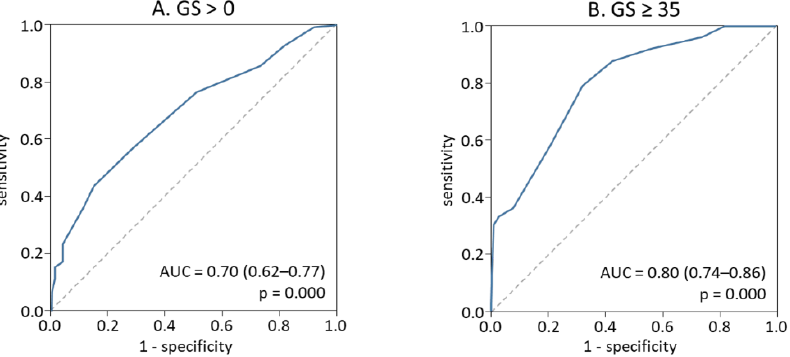
Figure 2. ROC-curve analysis for the prediction of coronary atherosclerosis presence ( A ) or severity ( B ) by i-BIO in the tested cohort.